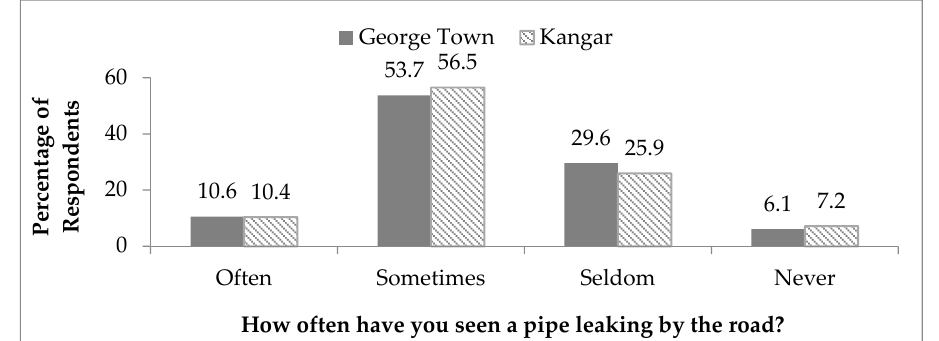
Figure 5. Experience of seeing pipe leaking or pipe burst by the road.